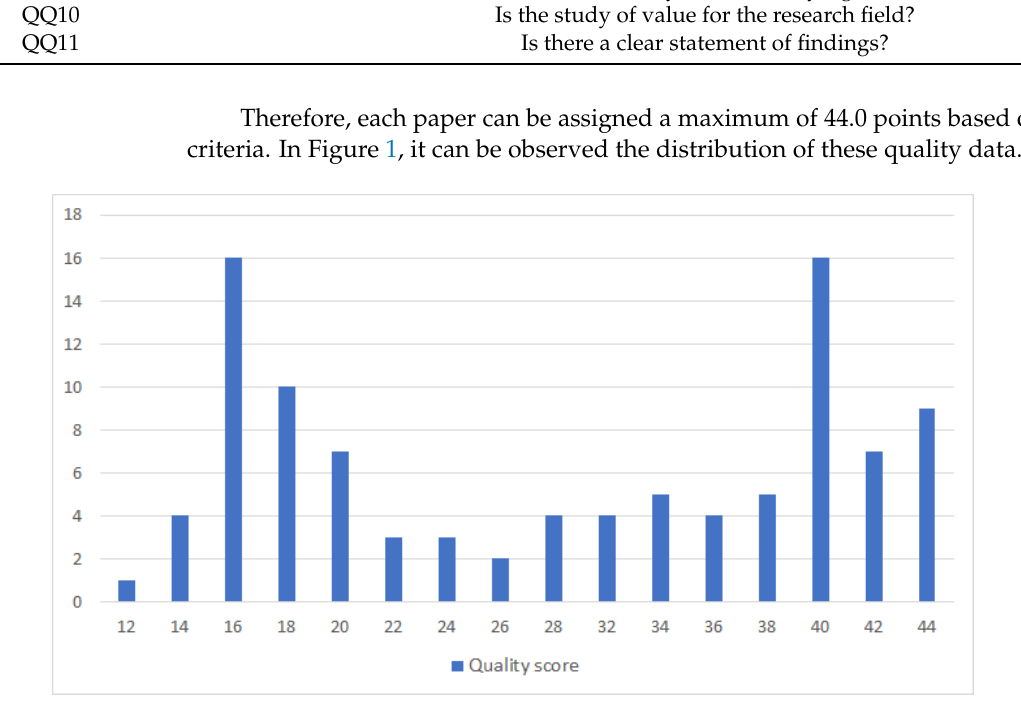
Figure 1. Distribution of Quality